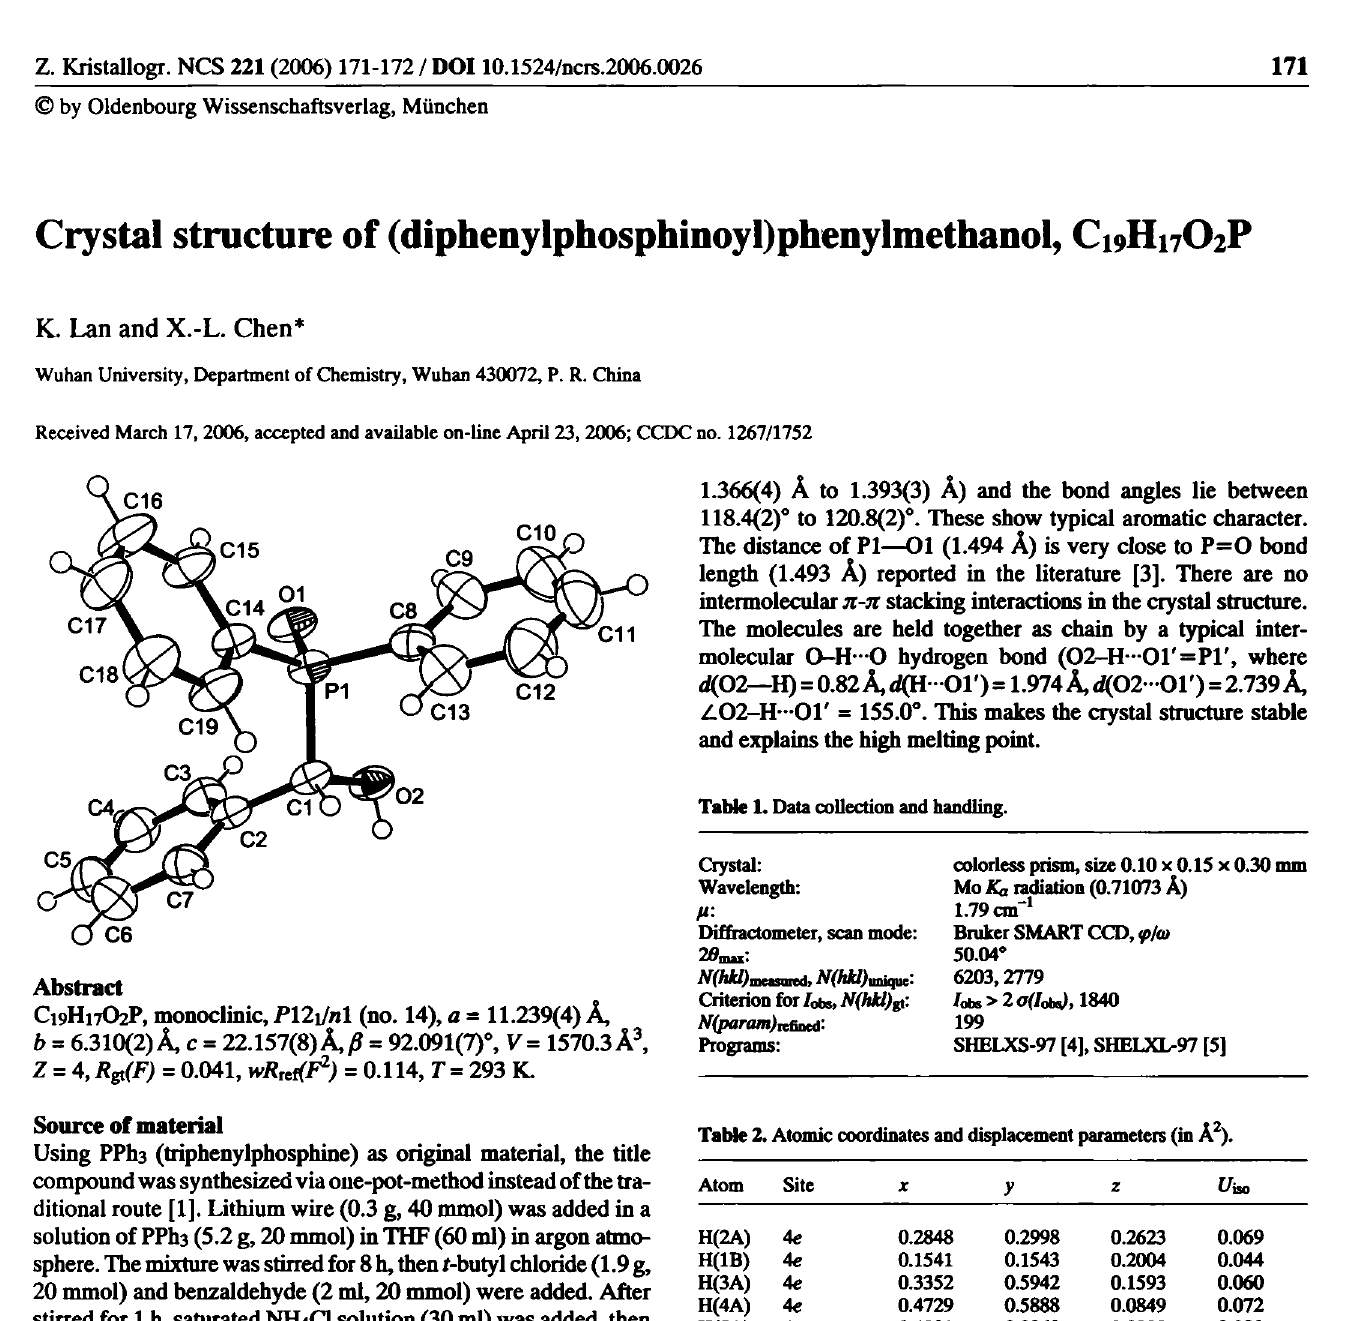
Table 2. Atomic coordinates and displacement parameters (in A 2 ).